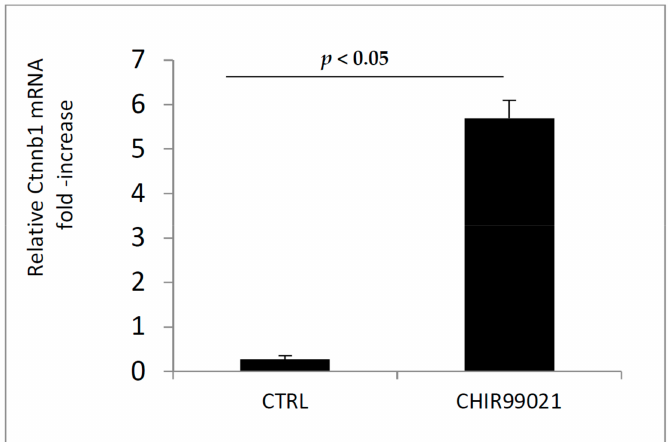
Figure 6. mRNA was extracted from MLO-Y4 cells treated or not with CHIR99021 at 100 nM for 48 h. The expression of β catenin gene (Ctnnb1) was evaluated by